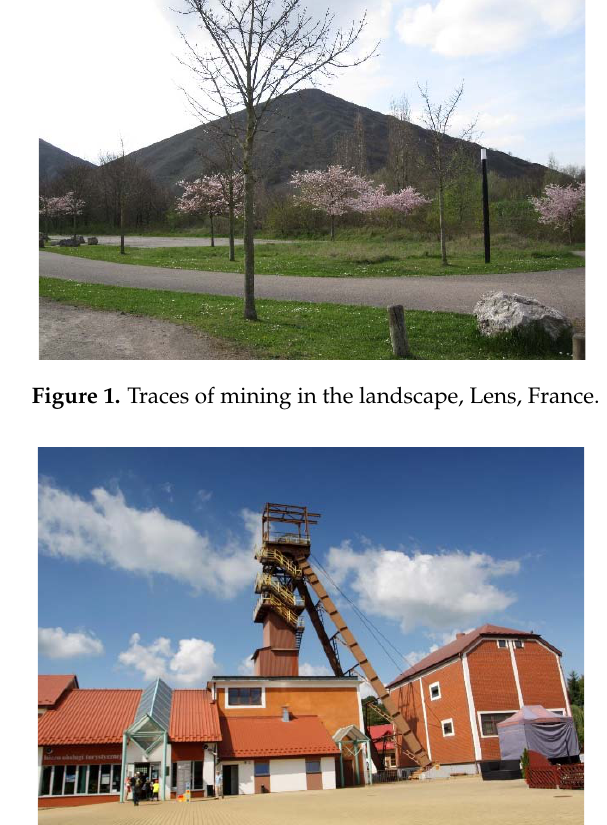
Figure 2. Entrance to the Mine Museum, Bochnia, Poland (photos by the authors).